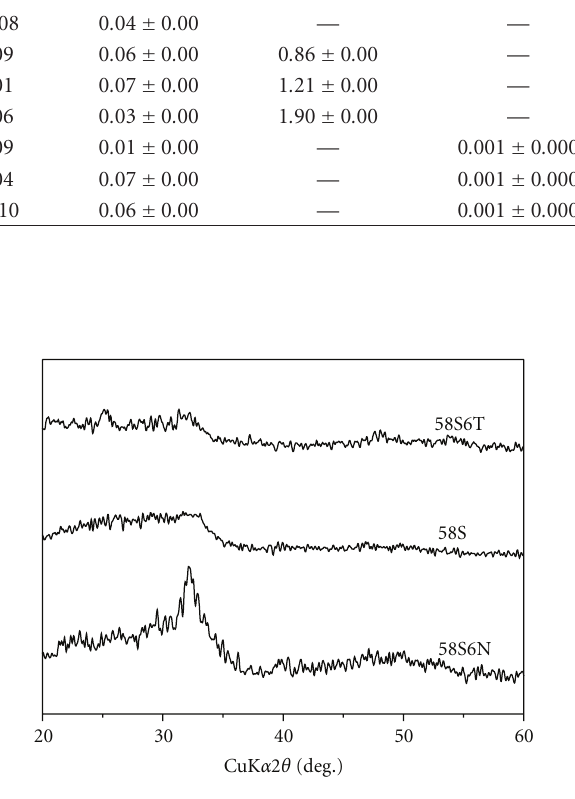
Figure 1: XRD patterns of the samples calcined at 700 ◦